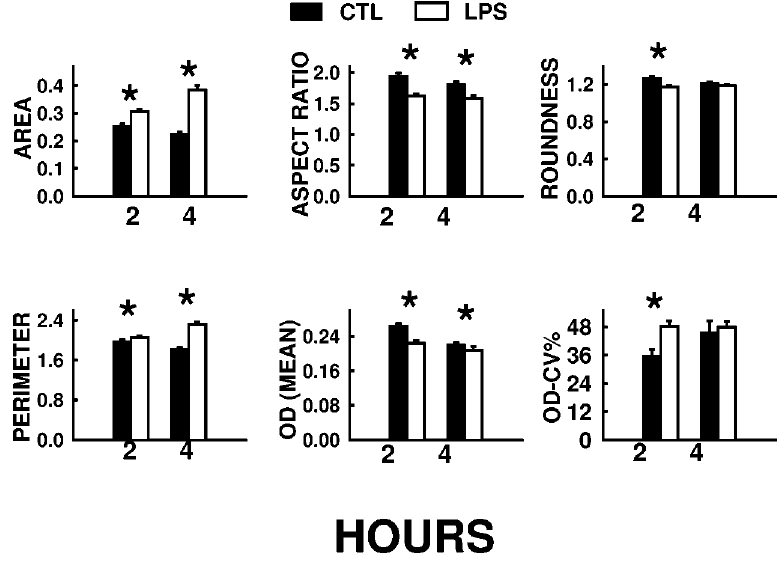
Fig. 3. Mean morphological assessments 2 and 4 hours after the administration of vehicle control or LPS. Two hours after LPS treatment, all measured morphological parameters demonstrated significant deviations from the Controls. LPS-induced changes in mitochondrial morphology included an increase in size, as reflected by greater perimeter and area measurements, and a more rounded shape, as reflected by a decrease in the aspect and roundness measurements. The mean optic density (OD) was reduced with the variation in optic density (OD-CV%) increased 2 hours post-treatment, perhaps related to the osmotic swelling of the mitochondria. Morphological parameters of area, aspect ratio, perimeter, and OD remained significantly different between the groups at 4 hours